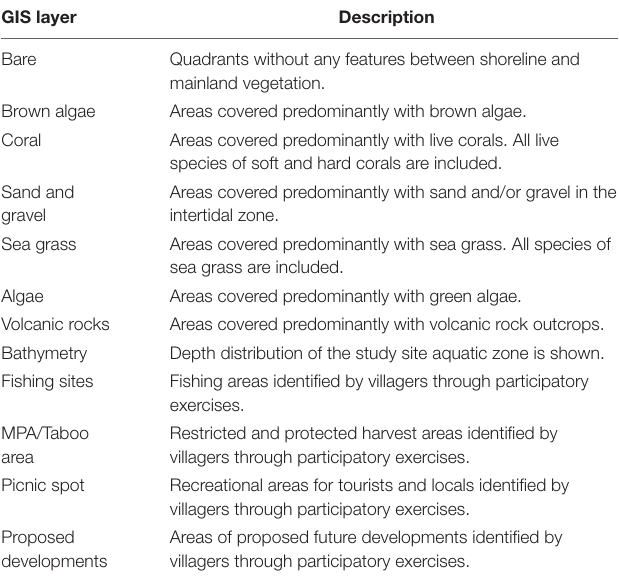
TABLE 3 | GIS layers for benthic habitat and local knowledge for Komave coastal region. GIS layer